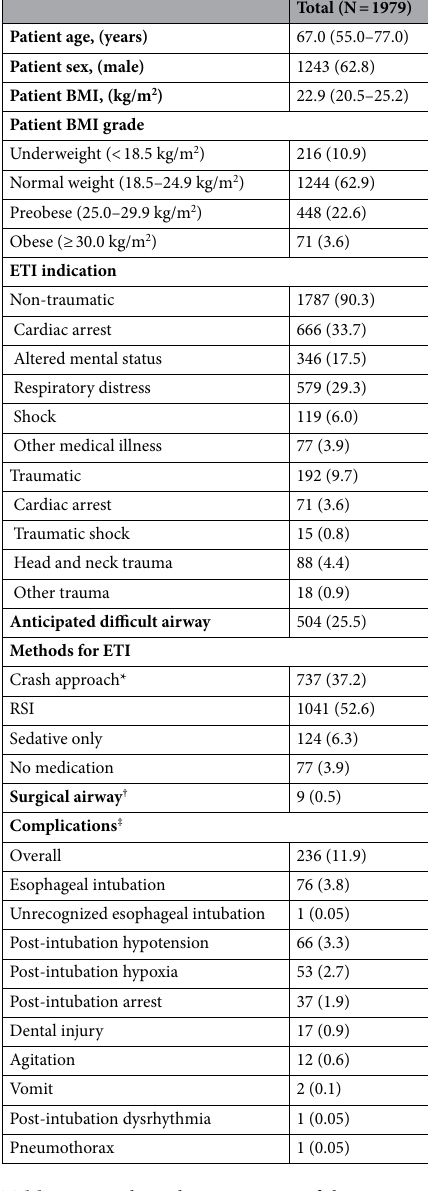
Table 1. Baseline characteristics of the patients. Data are presented as medians (interquartile ranges) or numbers (%). BMI body mass index, ETI endotracheal intubation, RSI rapid sequence intubation. *Crash approach: used for unconscious, unresponsive patients expected not to be resistant to laryngoscopy and who needed immediate airway security. † Patients whose airways have been secured with a surgical